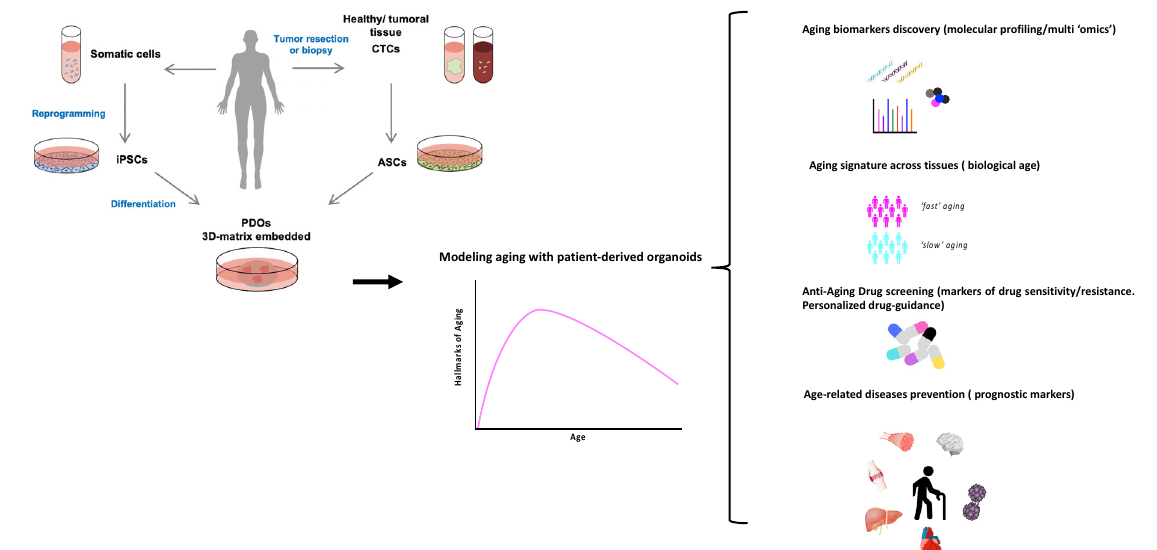
Figure 1. Patient-derived organoids (PDOs) as a personalized aging tool. PDOs can be obtained from reprogramming adult stem cells into uncommitted induced pluripotent stem cells (iPSCs), which through a series of differentiation steps result in the generation of the desired tissue type organoid. Alternatively, tumor resection or liquid biopsy/circulating-tumor cells (CTC) can be the source of the adult stem cell (ASCs) required to establish the organoid. Modeling aging with PDOs have a tremendous potential as a preclinical model tool to discover new biomarkers of aging, to predict adverse outcomes during aging, and to design personalized approaches for prevention and treatment of aging-related diseases and geriatric syndromes. This could represent a novel approach to study chronological and/or biological aging, paving the way to personalized interventions targeting the biology of aging.